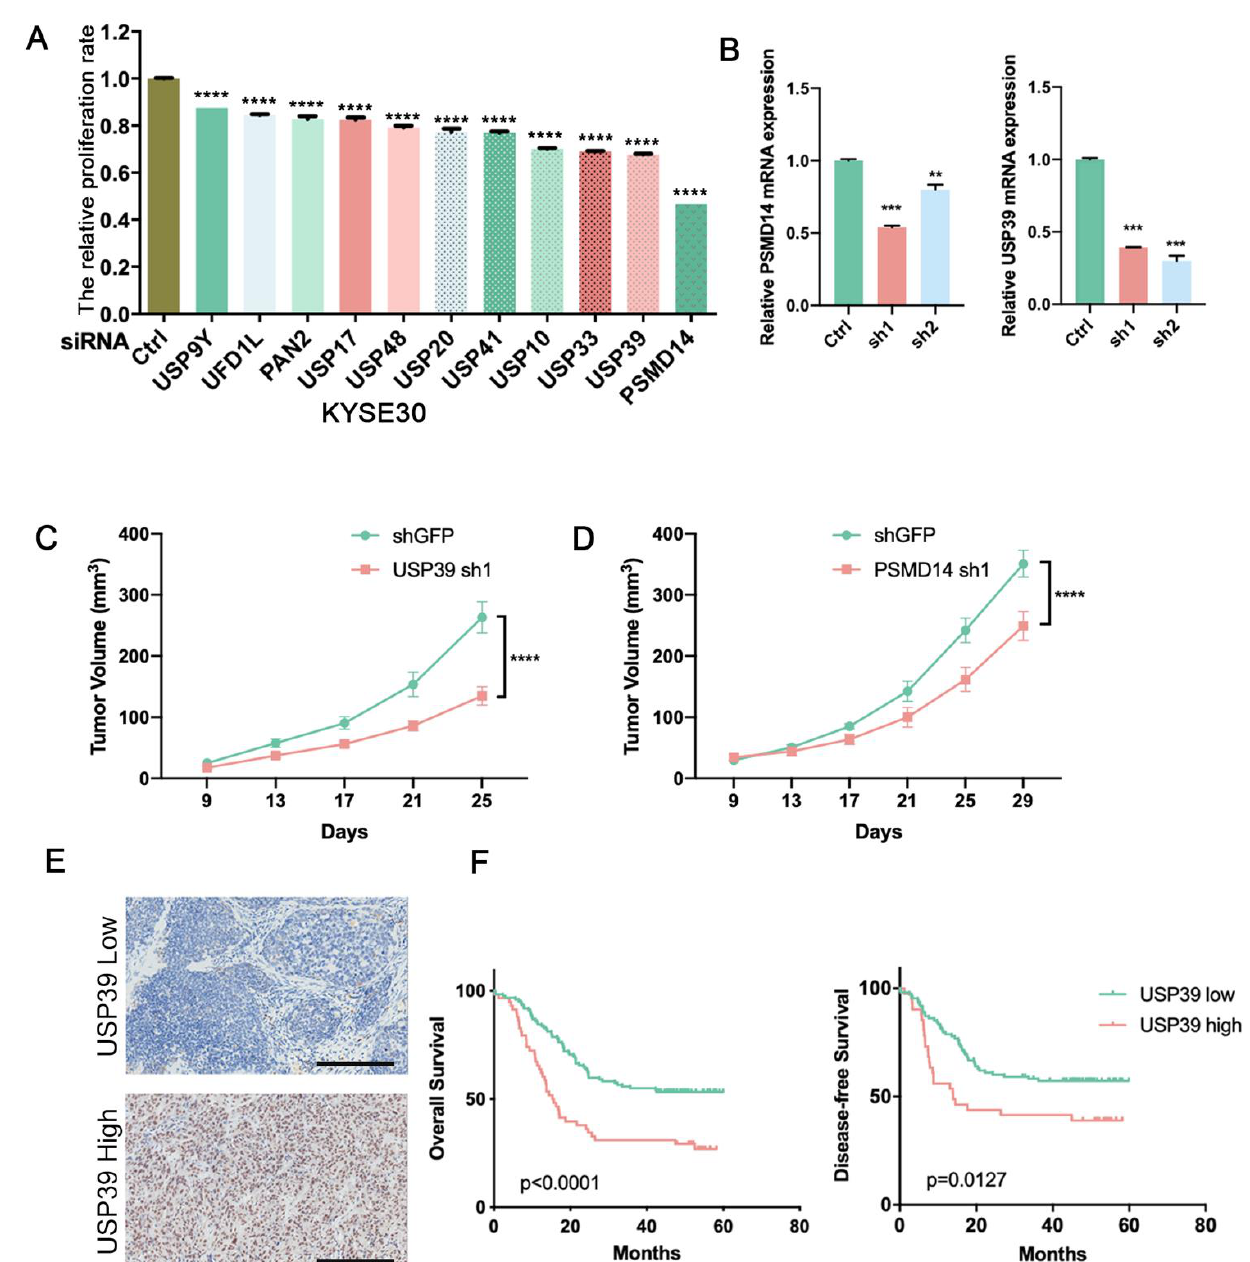
Figure 1. Identification of the DUB that promotes the proliferation of esophageal cancer cells. ( A ) Each of the 98 human DUB genes was suppressed in KYSE30 cells with pooled siRNAs and the cell proliferation was detected by the CCK-8 assay. ( B ) Knockdown efficiency of PSMD14 and USP39 in KYSE30 cells was examined by qRT-PCR. ( C ) Tumor volumes of USP39 silenced KYSE30 cells and control cells. n = 7 mice per group. ( D ) Tumor volumes of PSMD14 silenced KYSE30 cells and control cells. n = 7 mice per group. ( E ) Representative images of IHC staining of USP39 in USP39 high expression or USP39 low expression cases. Scale bars, 200 µ m. ( F ) Kaplan–Meier analysis of ESCC patients’ overall survival and disease-free survival grouped by low or high expression of USP39 by the log rank test. Data in A, B, C, D are shown as the mean ± S.D. Data were analyzed by one-way ANOVA with Bonferroni correction ( A , B ) or two-way ANOVA with Bonferroni correction ( C , D ). ** p < 0.01, *** p < 0.001, **** p < 0.0001.